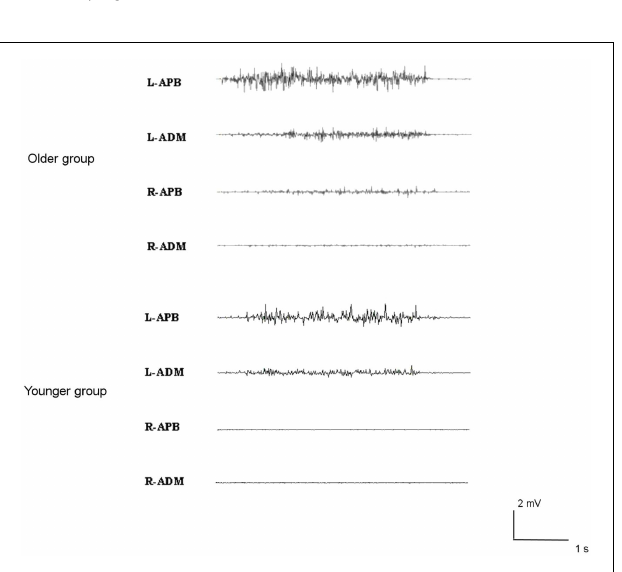
right ISP area : a smaller right ISP area is associated with worse motor performances with both upper limbs in NHPT (for right NHPT p = 0.021, ρ = 0.499; for left NHPT p = 0.006, ρ = 0.576), FT (for right FT p = 0.009, ρ = − 0.555; for left FT p = 0.027, ρ = − 0.483), and grip strength (R: p = 0.024, ρ = − 0.492; L: p = 0.049, ρ = − 0.435). There were no further significant correla- tions with the other variables